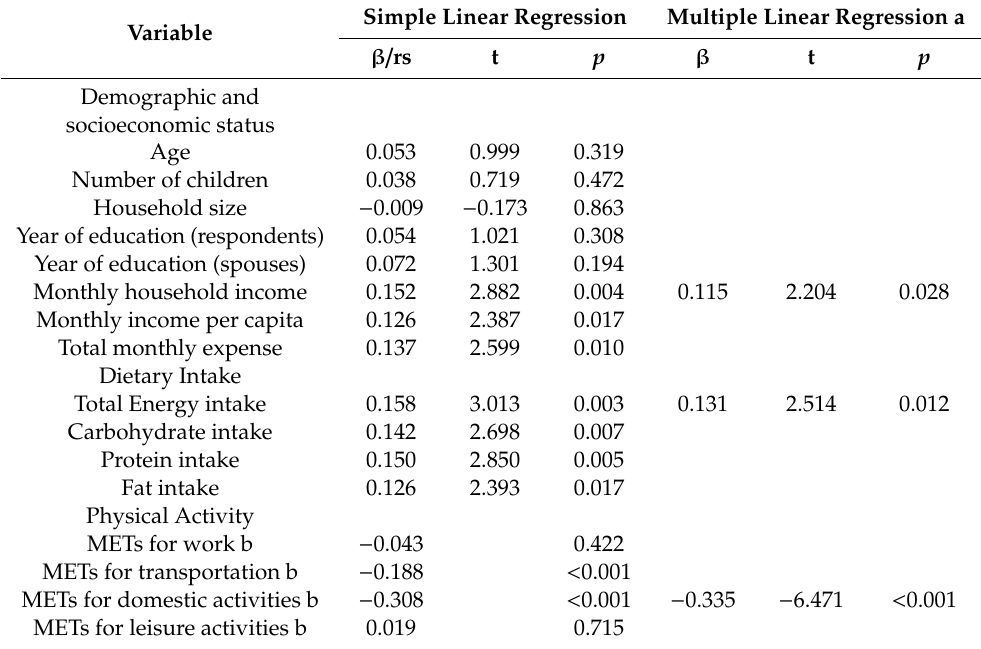
Table 3. Correlations and contributions of demographic and socioeconomic status, dietary intake, and physical activity with body mass index (BMI, n = 355).